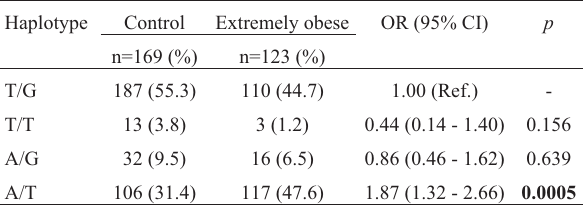
Table 3 - Association of FTO haplotypes with obesity